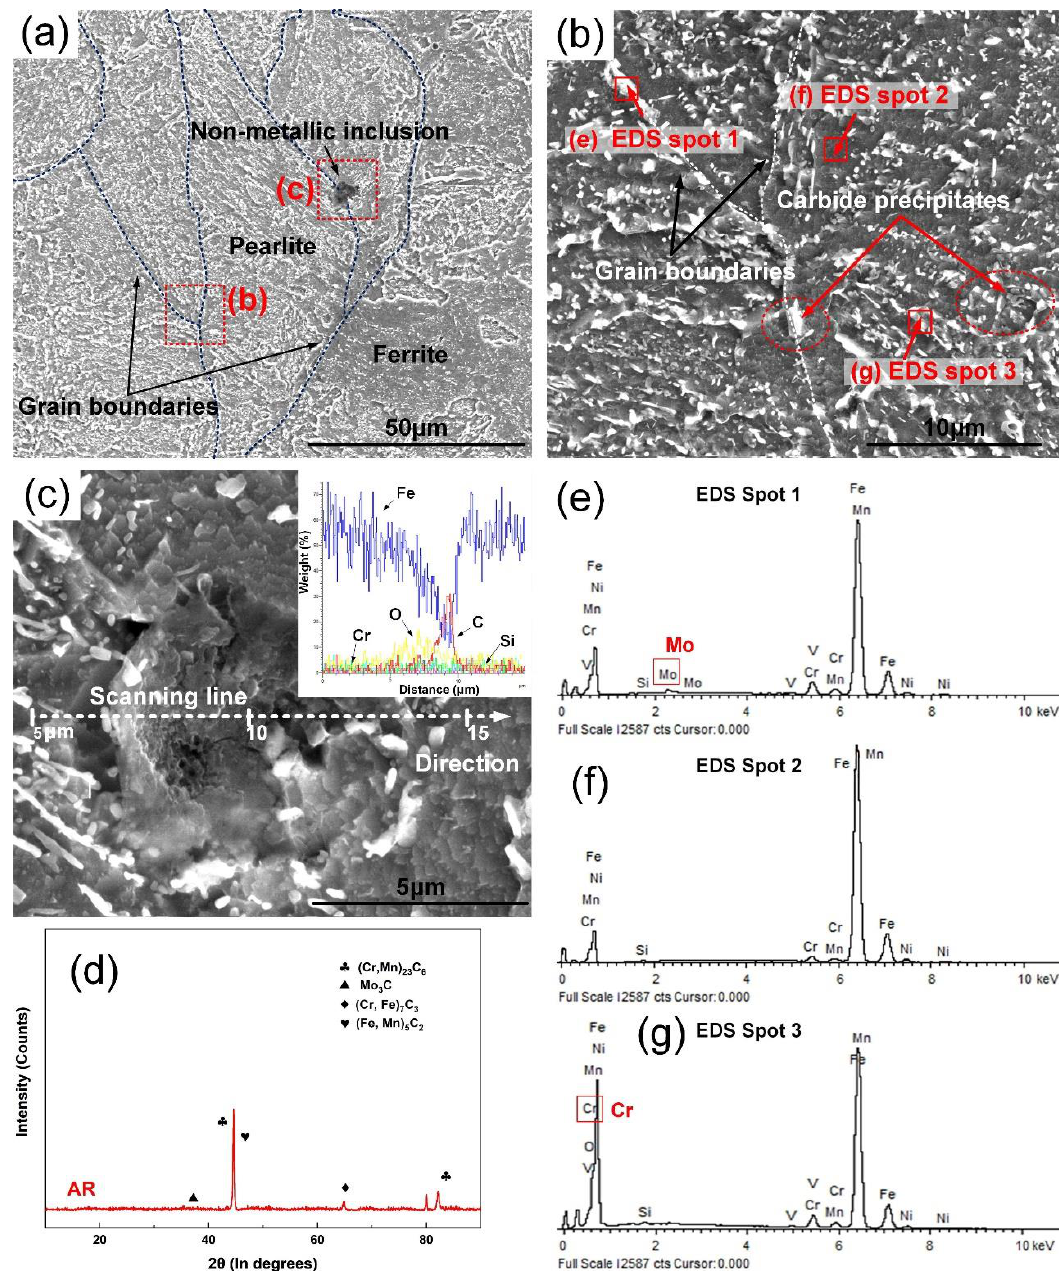
Figure 10. Scanning electron microscope (SEM) micrographs of 25CrNi2MoVE steel under AR state: ( a ) at 2500× and ( b ) 10000× magnification; ( c ) Energy dispersive spectrometer (EDS) line scanning spectrum of non-metallic inclusion; ( d ) surface X-ray diffraction (XRD) pattern under AR state; ( e ) EDS spectrum of EDS spot 1 (carbide precipitates on grain boundaries), ( f ) EDS spot 2 (ferritic matrix) and ( g ) EDS spot 3 (carbide precipitates inside grain boundaries).